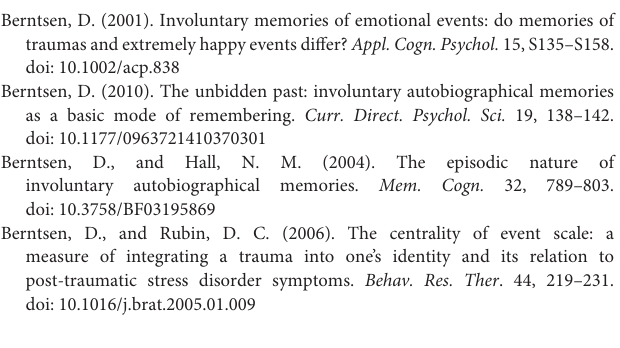
interventions and should be further tested in clinical PTSD